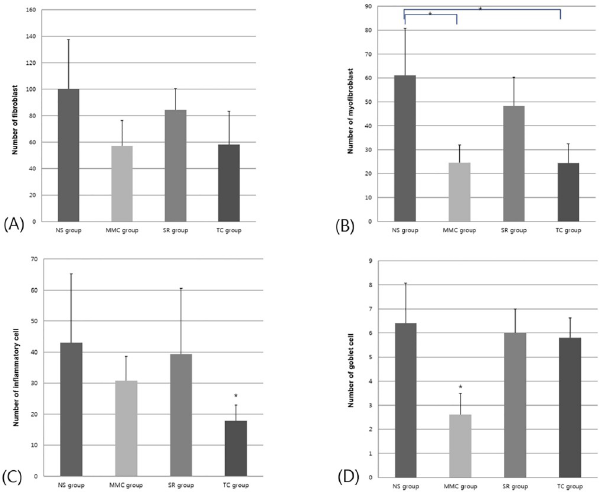
Fig 6. Histological outcomes of the conjunctiva and Tenon’s capsule. (A) The number of fibroblast showed no significant difference among the four groups. (B) The number of myofibroblasts significantly reduced in the MMC and TC groups. (C) The TC group had the lowest number of inflammatory cells among all groups (D) and the MMC group had the lowest number of goblet cells among all groups. NS = 0.9% normal saline, MMC = 0.5% mitomycin C, SR = sirolimus, TC = tacrolimus. � = significant difference in conjunctival congestion at 1 week among all groups ( p < 0.05, Kruskal–Wallis test and Games–Howell adjustment).